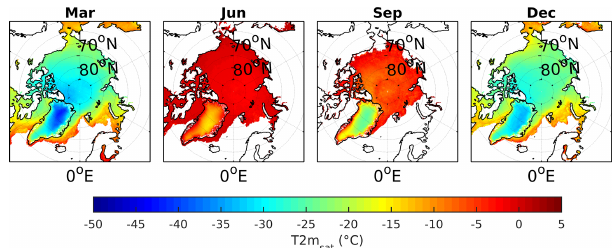
Figure 13. Monthly mean T2m sat during March, June, September, and December, averaged for the period